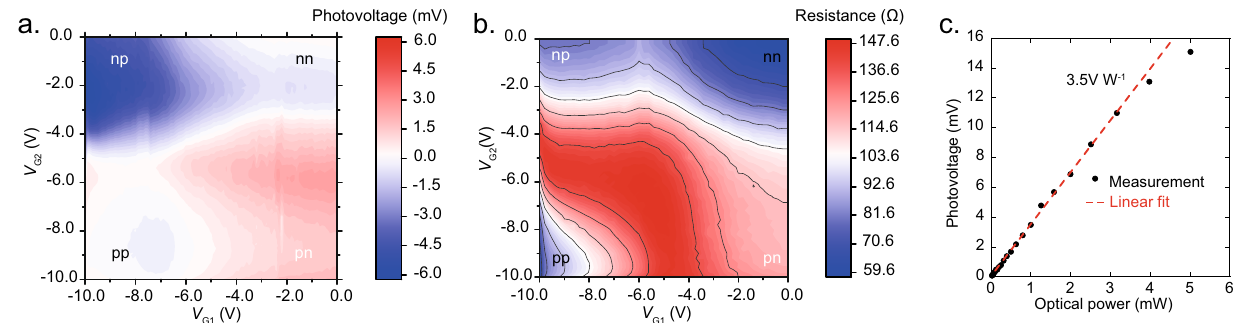
Fig. 3 DC characterization. a Measured photovoltage map of the fabricated PTE graphene photodetector ( L = 1.5 µ m and W = 50 μ m) as a function of the gate voltages V G1 and V G2 . Optical input was ~1.65 mW at the detector input facet. b Measured resistance map of the fabricated PTE graphene photodetector ( L = 1.5 µ m and W = 50 μ m) as a function of the gate voltages V G1 and V G2 . c Photovoltage as a function of the optical power at the detector input facet. Black dots are experimental values, the red dashed line represents the linear fi t.